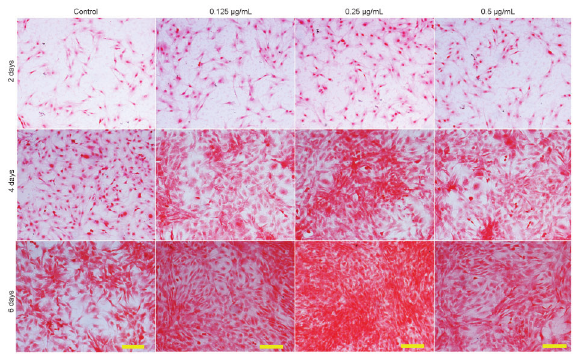
Figure 6. Laser-scanning confocal microscopy images showing the viability of chondrocytes cultured in vitro with 0 (control),